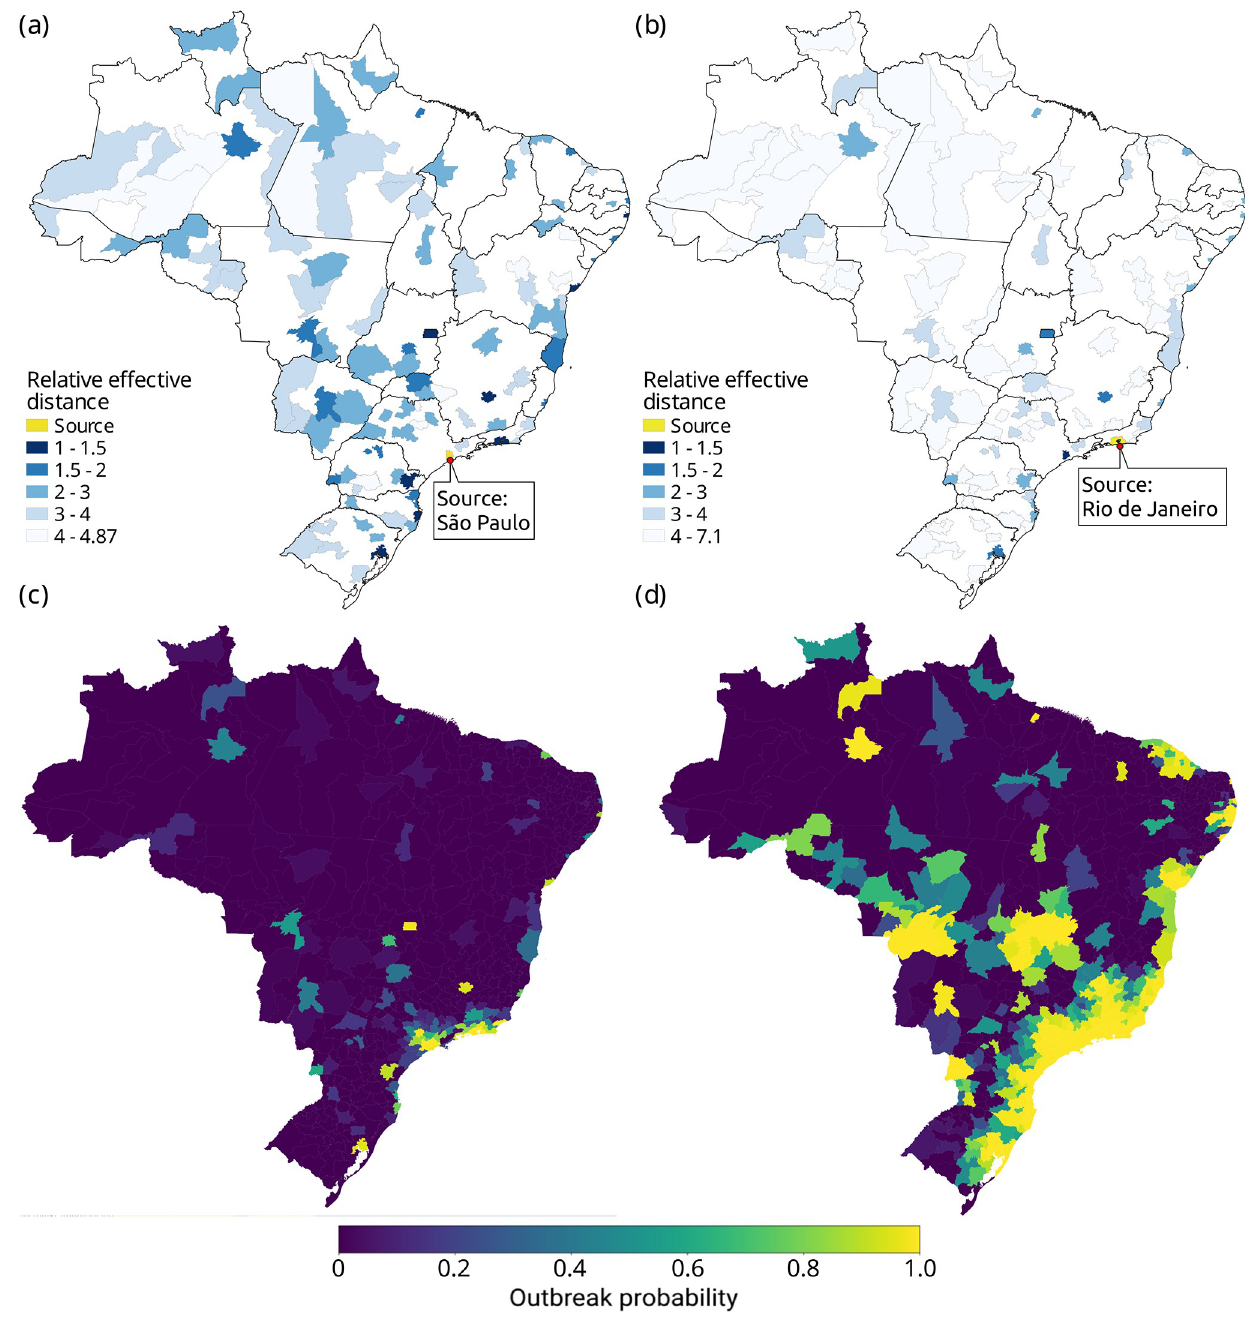
Fig 1. Effective distance from the two initial COVID-19 hotspots in Brazil. (a) Relative effective distance ( e f ) of Brazilian micro-regions from S ã o Paulo based on airline network in the absence of travel restrictions. (b) The same from Rio de Janeiro, with blue gradient from closest (dark blue) to farthest (light blue) destinations, limited to those present on the airline network. (c) Probability of COVID-19 outbreak per micro-region as Rio de Janeiro and S ã o Paulo sustain high prevalence of infection. (d) Second round of outbreaks after the micro-regions infected in (c) begin to contribute cases, with a gradient from dark purple ( p = 0) to bright yellow ( p =